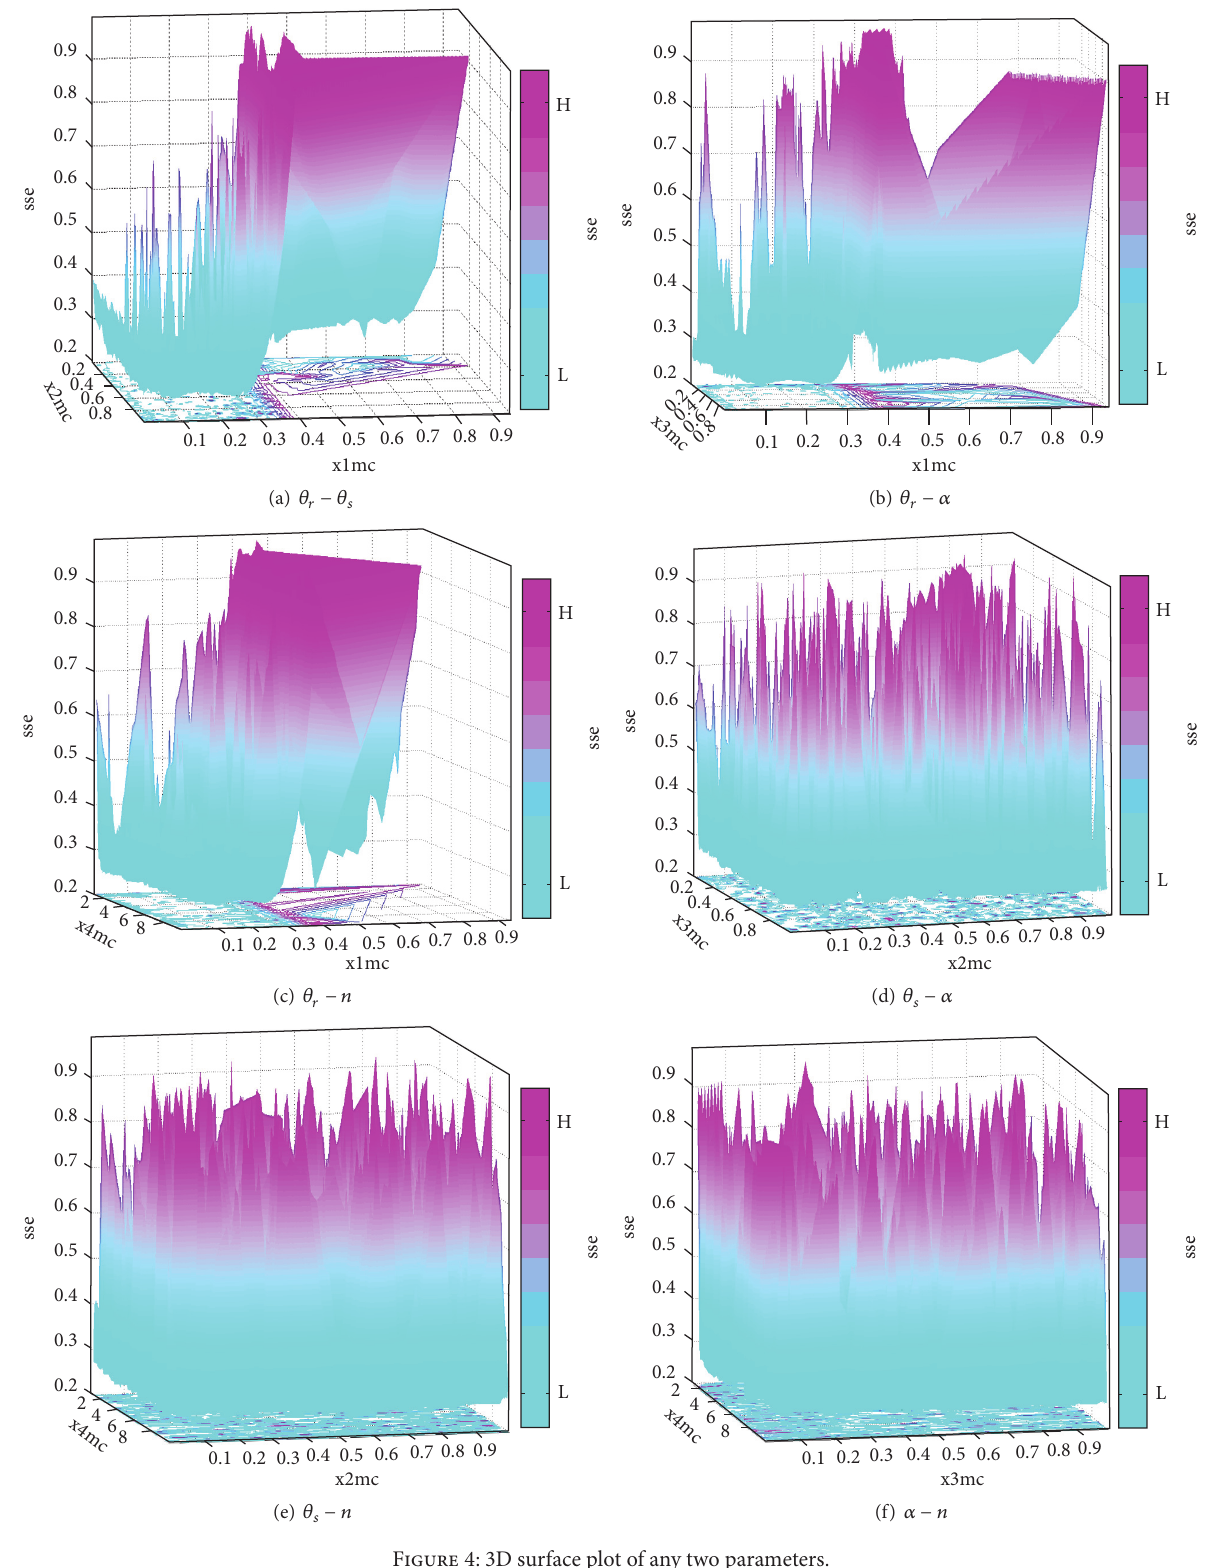
Figure 4: 3D surface plot of any two